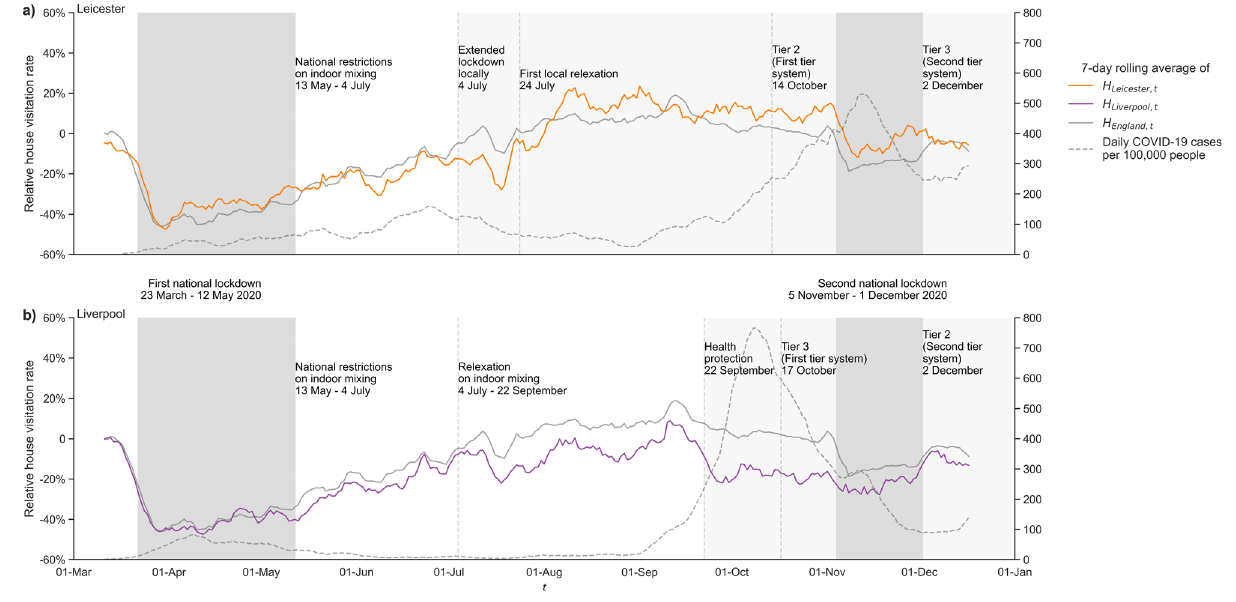
Figure 4. Change in H l , t in ( a ) Leicester and ( b ) Liverpool from March 2020 to December 2020, where regional health protections regulations were implemented.